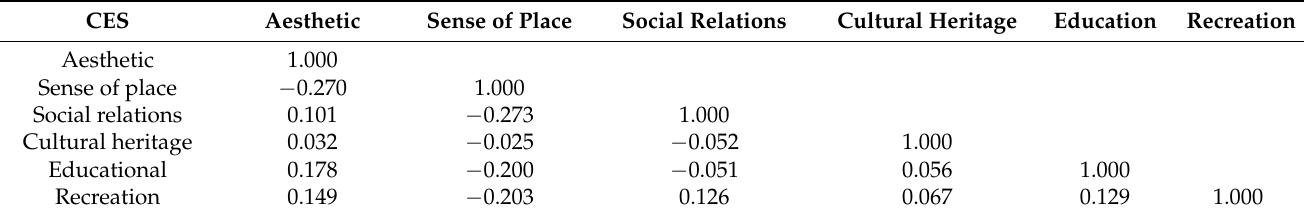
Table 3. Bivariate local Moran’s I among six cultural ecosystem service supplies in Shigou Township.